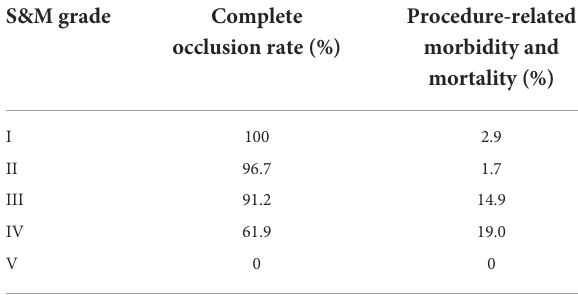
TABLE 2 Occulusion rate and procedure-related morbidity and mortality in different S&M